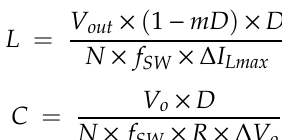
Figure 15 . Charging station with common DC bus. 5.1. AC-DC Stage 5.1.1. Three-level three-phase NPC converter The three-level three-phase NPC converter as shown in Figure 16, offers high-power capacity and flexible ways for connecting the input sources [140]. It is also able to produce a five-level output voltage in comparison to the VSI converter. This results in a lower dv/dt rating, a smaller filtering requirement, and a better current performance. However, the NPC converter has an inherent issue, which is the imbalanced power between the positive and negative DC-bus; this imbalanced power can lead to producing an inferior grid-side current that can create instability regarding the grid. 5.1.2. Three-phase bridgeless boost converter The three-phase bridgeless boost converter, as shown in Figure 17, takes advantages of the boost Power factor correction (PFC) converter. Numerous control schemes of this topology are discussed